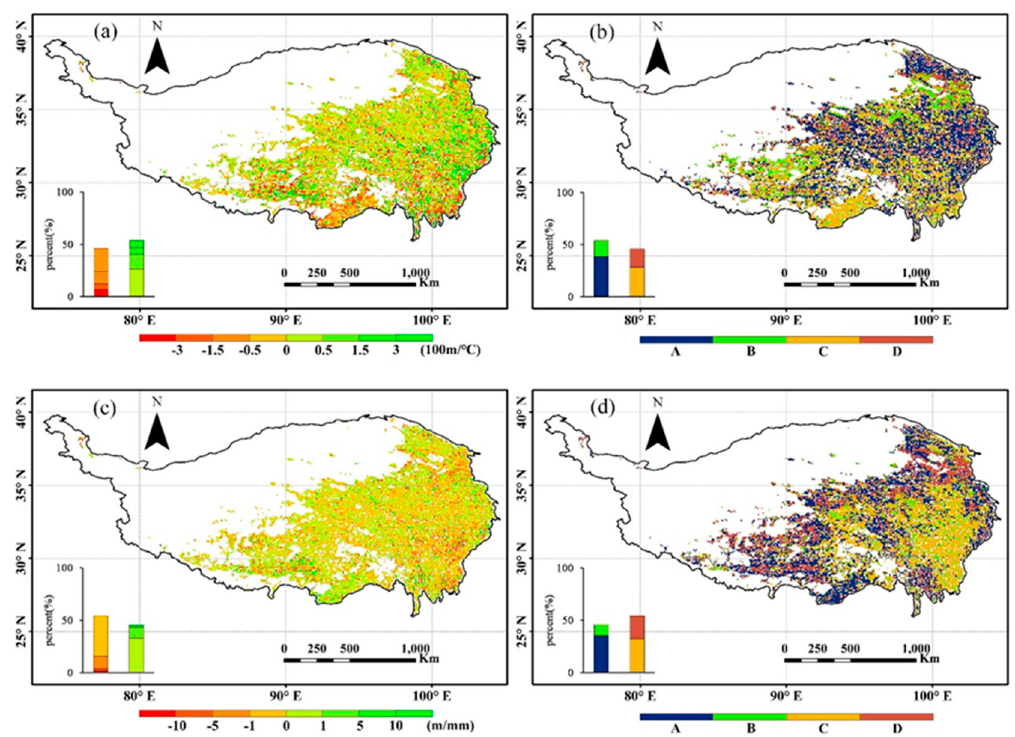
Figure 4. Distributions of ( a ) the sensitivity of the NDVI GS isolines elevational movements to temperature (S_NDVI GS _T), ( b ) the direction of the sensitivity of the NDVI isolines elevational movement to temperature, ( c ) the sensitivity of NDVI GS isolines elevational movement to precipitation (S_NDVI GS _P), and ( d ) the direction of the sensitivity of the NDVI isolines elevational movement to precipitation. A, B, C, and D modes in ( b , d ) are defined in Figure 1. The bar charts in the lower-left corner of each graph show the percentage of pixels in each interval.